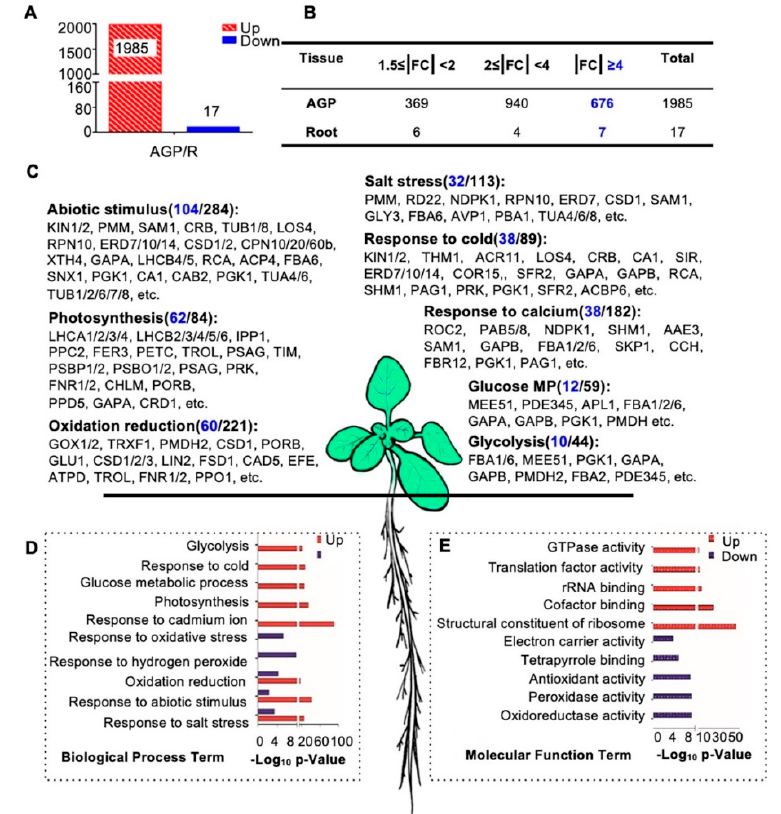
Figure 4. Biological process and molecular function enrichment analysis of AGP-root differentially expressed proteins. ( A ) Numbers of differentially expressed proteins in the comparison of above-ground parts (AGP) and roots in 16-day-old plants: 1985 proteins up-regulated and 17 proteins were downregulated in aboveground parts. ( B ) Detailed distribution of differentially expressed proteins. The highlighted number denotes numbers of protein with |FC| ≥ 4. ( C ) Biological process enrichment of upregulated proteins in the AGP. The highlighted number denotes numbers of protein with |FC| ≥ 4. ( D ) Biological process enrichment of differentially expressed proteins in AGP. ( E ) Molecular function enrichment of differentially expressed proteins in the aboveground parts. Counts in blue indicate the number of proteins with fold changes greater than four. The p -value is the enrichment score (E-score) from DAVID (http://david.abcc.ncifcrf.gov/). Higher-log10 p-values indicate more significant enrichment.